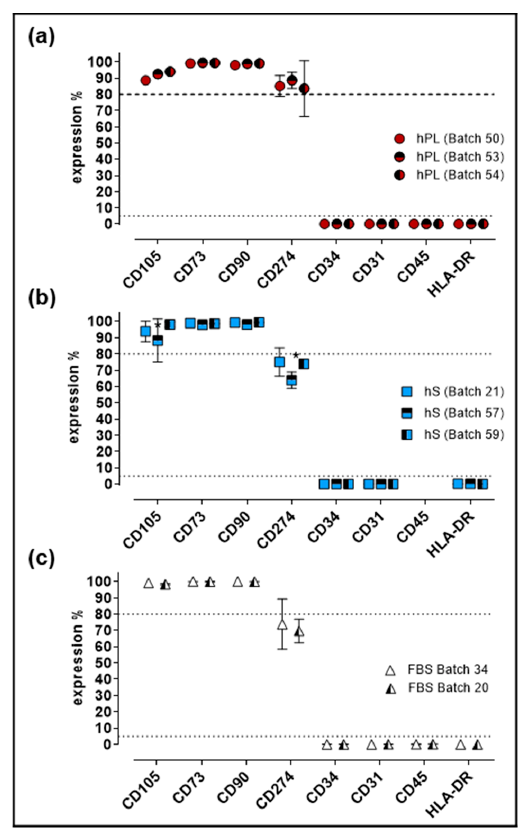
Figure 5. Immunophenotypic profile of WJ-MSC expanded with hPL, hS and FBS. ( a ) Percentage of expression of MSC markers present in WJ-MSC expanded with different batches of hPL ( n = 3 batches); ( b ) hS ( n = 3 batches) and ( c ) FBS ( n = 2 batches); Data is shown as mean ± SD, * p < 0.05 analyze by Tukey’s